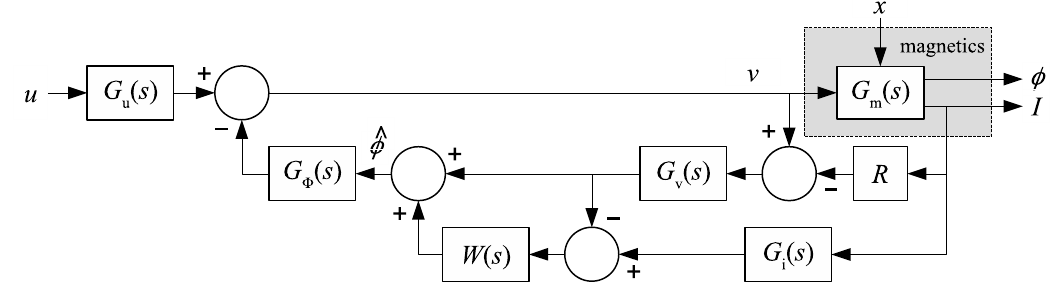
Figure 1. Generalized amplifier